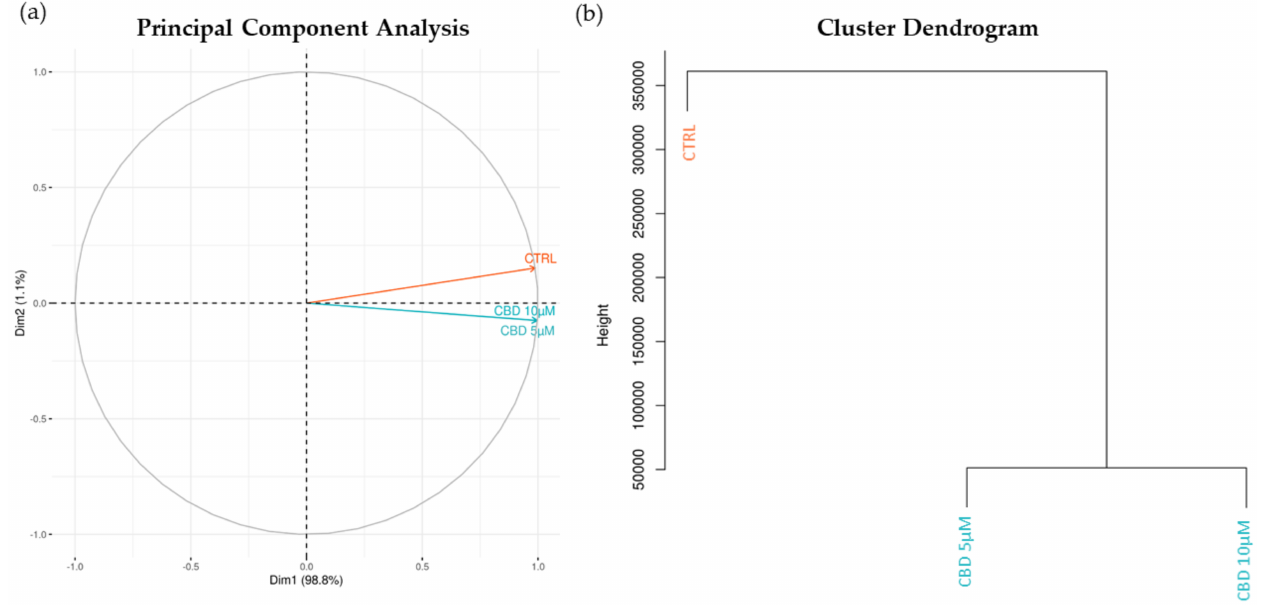
Figure 2. Principal Component Analysis (PCA) ( a ) and Cluster Dendrogram ( b ) of the CTRL and CBD groups obtained from the transcriptomic profile. In orange, we can see the CTRL group, whereas in blue, CBD 5 µ M and CBD 10 µ M are represented. Both the PCA and the dendrogram show that the two groups treated with CBD are both very distant from the CTRL